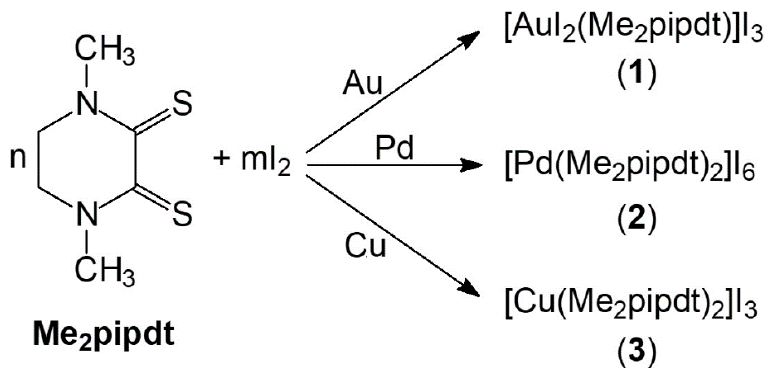
Scheme 3. Reaction scheme for gold, palladium and copper powder dissolution by Me 2 pipdt/I 2 mix-